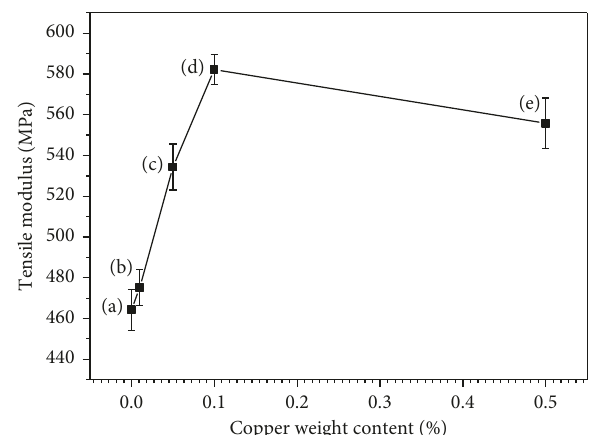
Figure 8: Tensile modulus: (a) nylon 6 and nanocomposites with (b) 0.01, (c) 0.05, (d) 0.10, and (e) 0.50wt.% of copper